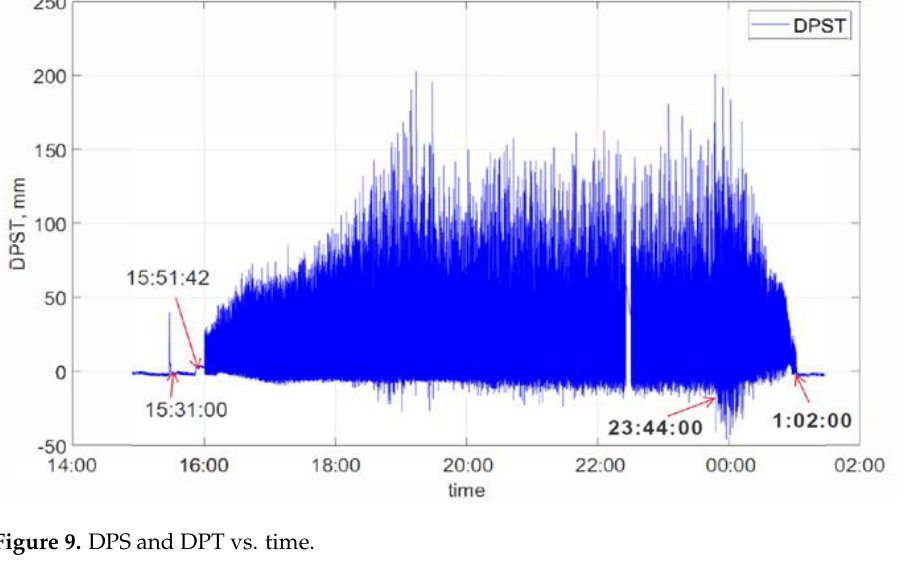
Figure 9. DPS and DPT vs. time.